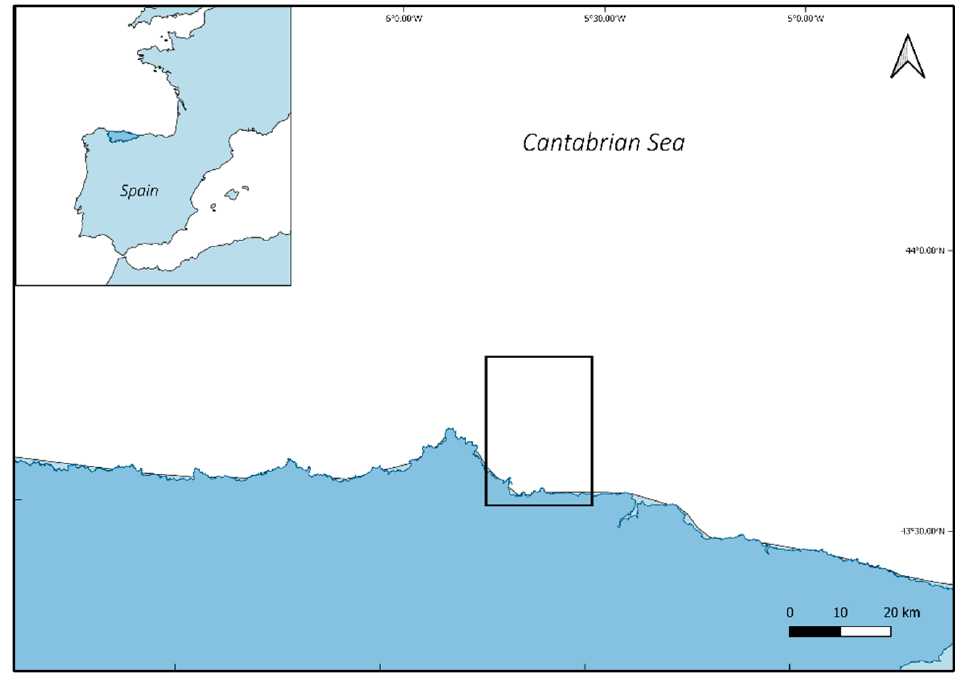
Figure 1. Fishing area where the analysed hakes were caught, and water samples taken (Geographical coordinates 43°35 ′ 00.0 ″ N 5°30 ′ 00.0 ″ W and nearby).